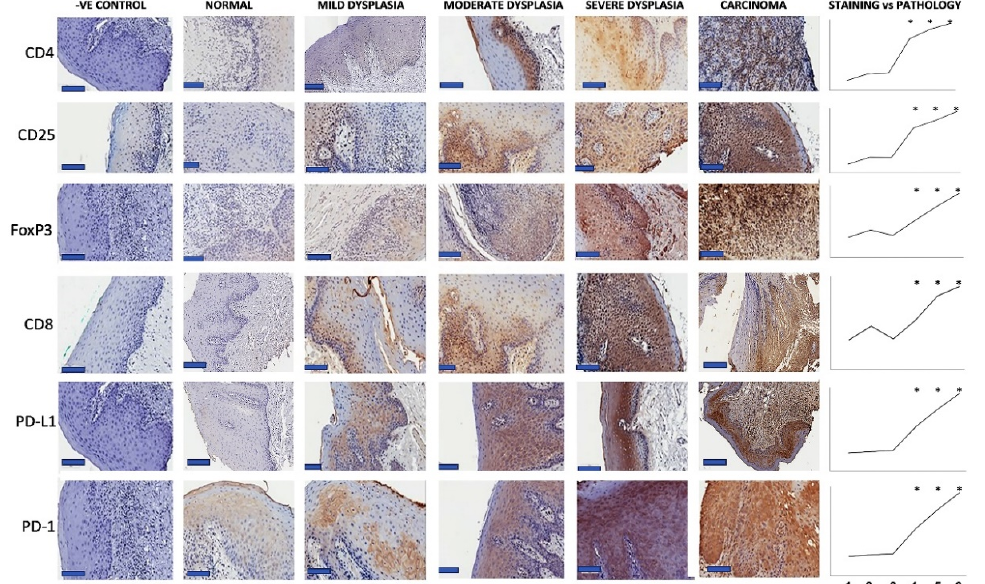
Figure 1. Infiltrating lymphocytes and immune checkpoint expression levels increase in parallel with oral cancer progression. Immunohistochemical analysis of immune markers in patient clinical samples pathologically defined as normal mucosa, pro-gressive grades of dysplasia (mild, moderate, and severe dysplasia) and carcinoma. Representative images are shown at total magnification 400(×) (scale bar, 100 µm). Average IHC staining for each immune marker was calculated and correlated with pa-thology (ordinal scale). The Y-axis in the graph indicates the IHC score and the X-axis indicates the pathological distribution of patient cohorts 1-normal, 2- parakeratosis (images not shown), 3-mild dysplasia, 4-moderate dysplasia, 5-severe dysplasia and 6-carcinoma. Pathology cohorts whose IHC staining value is significantly different from the normal group are indicated (*, p < 0.05) Table 3. T cell, checkpoint molecule and chemokine quantitation in oral potentially malignant and malignant lesions.